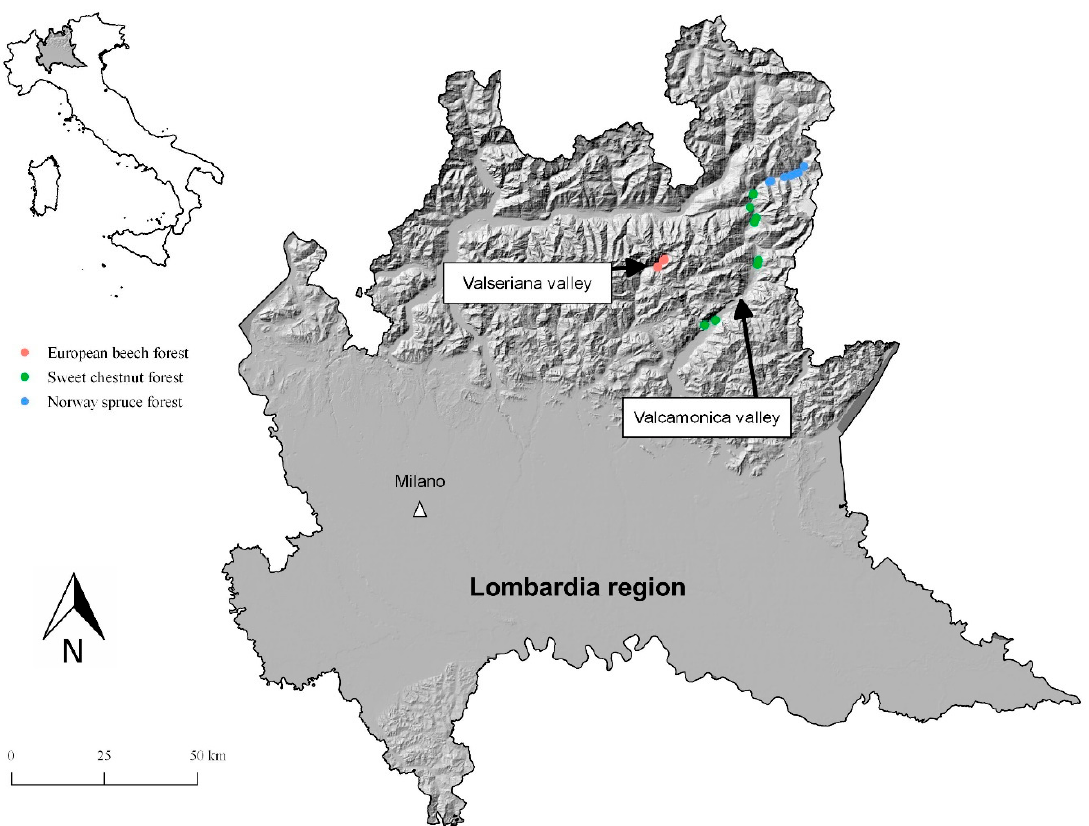
Figure 1. The study area is located in northern Valcamonica and in northern Valseriana, two alpine valleys of the Lombardia region, in the southeastern Italian Alps.